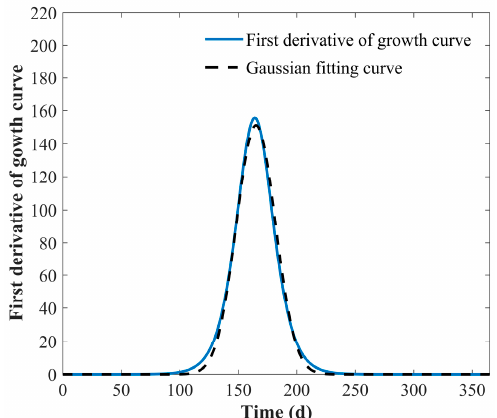
Figure 11. First derivatives of growth curve and its Gaussian fitting curve. We calculated the proportion area of the first-order derivative of the growth curve corresponding to the start and dissipation times of the green tide according to the growth curve area proportion calculation method described in Section 3.8. The start and dissipation times of the green tide event were determined according to the China Marine Disaster Bulletin and the Jiangsu Marine Disaster Bulletin, as shown in Table 8. For periods that were not accurate to days, the 15th day was considered as the middle, the 20th day as mid- late, and the 25th day as late. Table 8. Start and dissipation times of the green tide event. Year